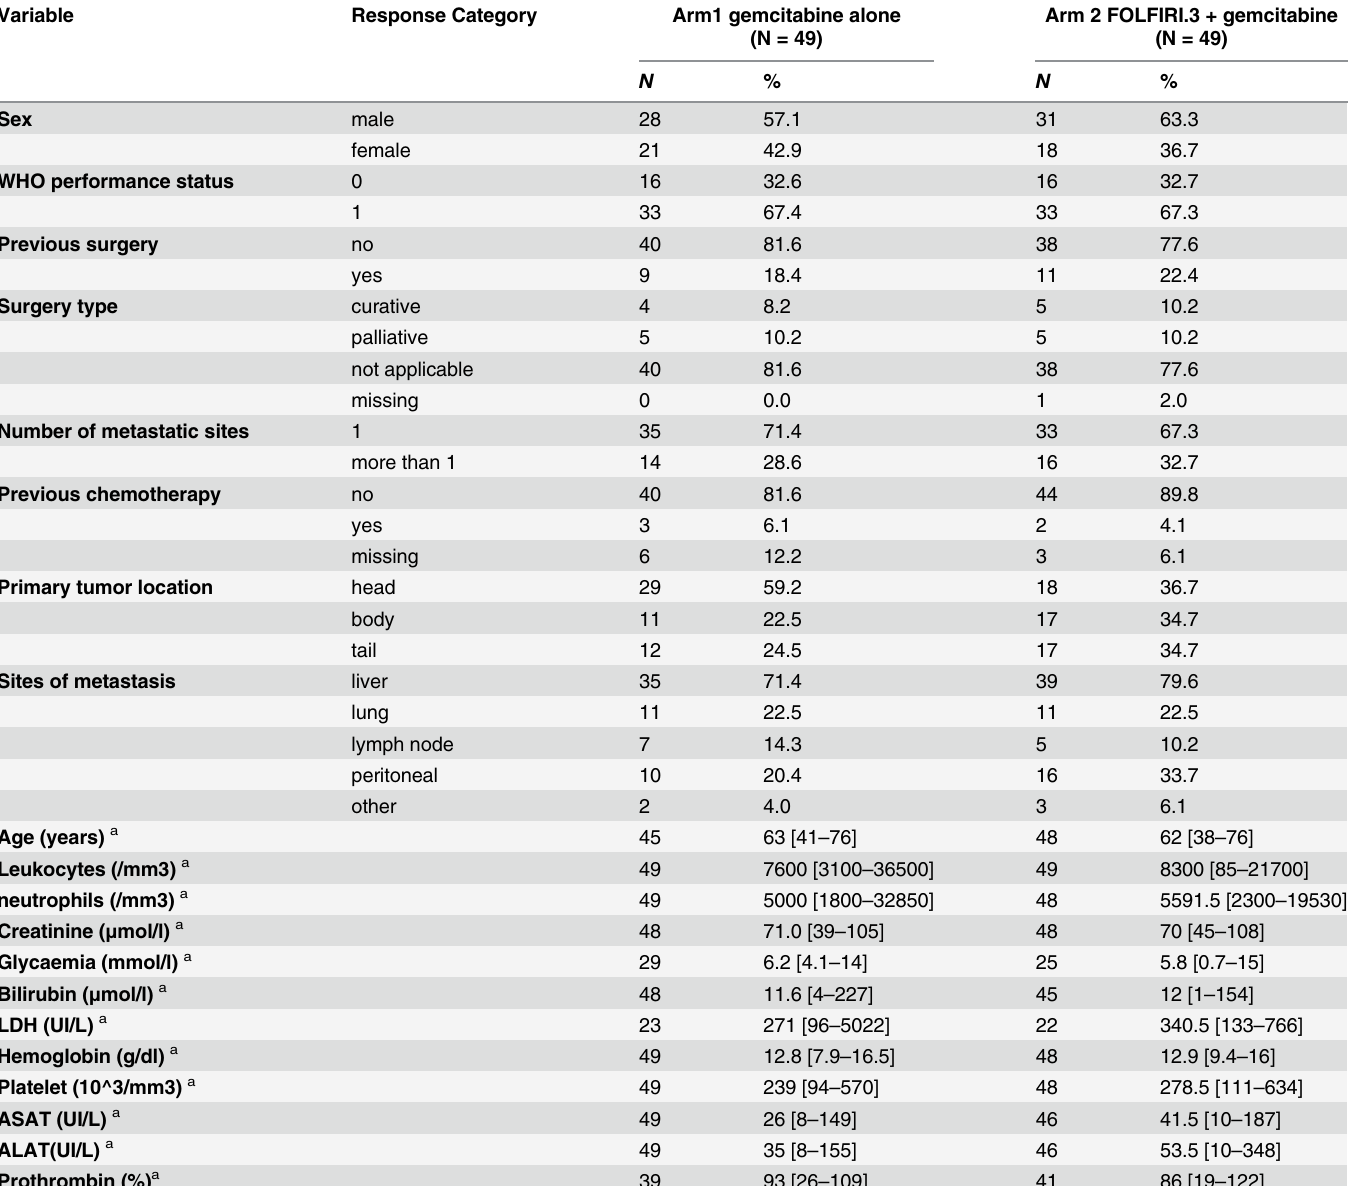
Table 1. Baseline characteristics of patients included according to treatment arm.